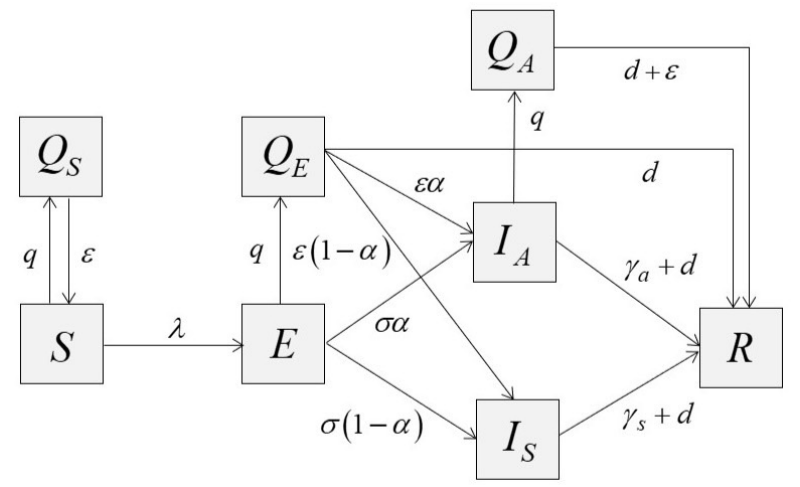
Figure 1. SEIR model with